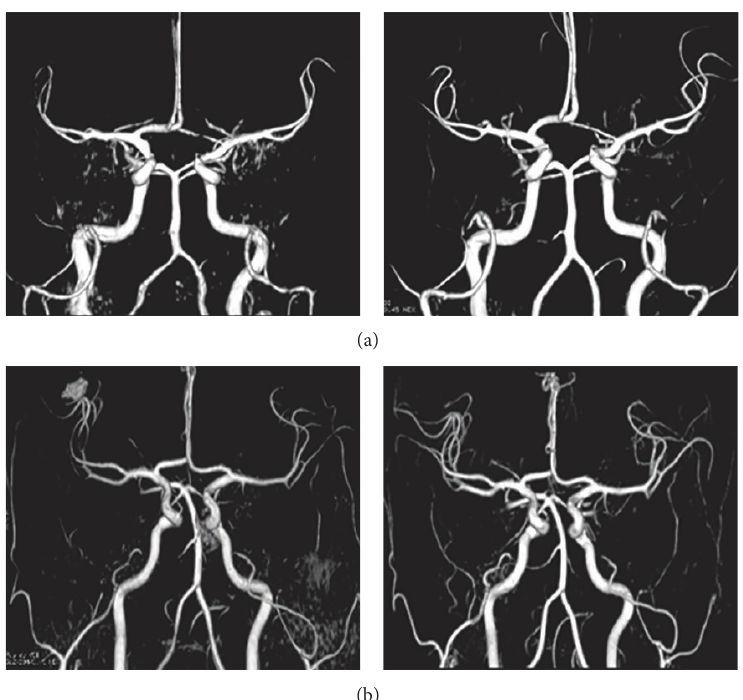
Figure 3: MRA evolutions in Patient 1 and Patient 3. (a) Reversible vasospasm of vertebral arteries with PCA, MCA, and ACA spasms in Patient 1. (b) Reversible vasospasm of vertebrobasilar arteries along with invisibility of more distal cerebral arteries in Patient